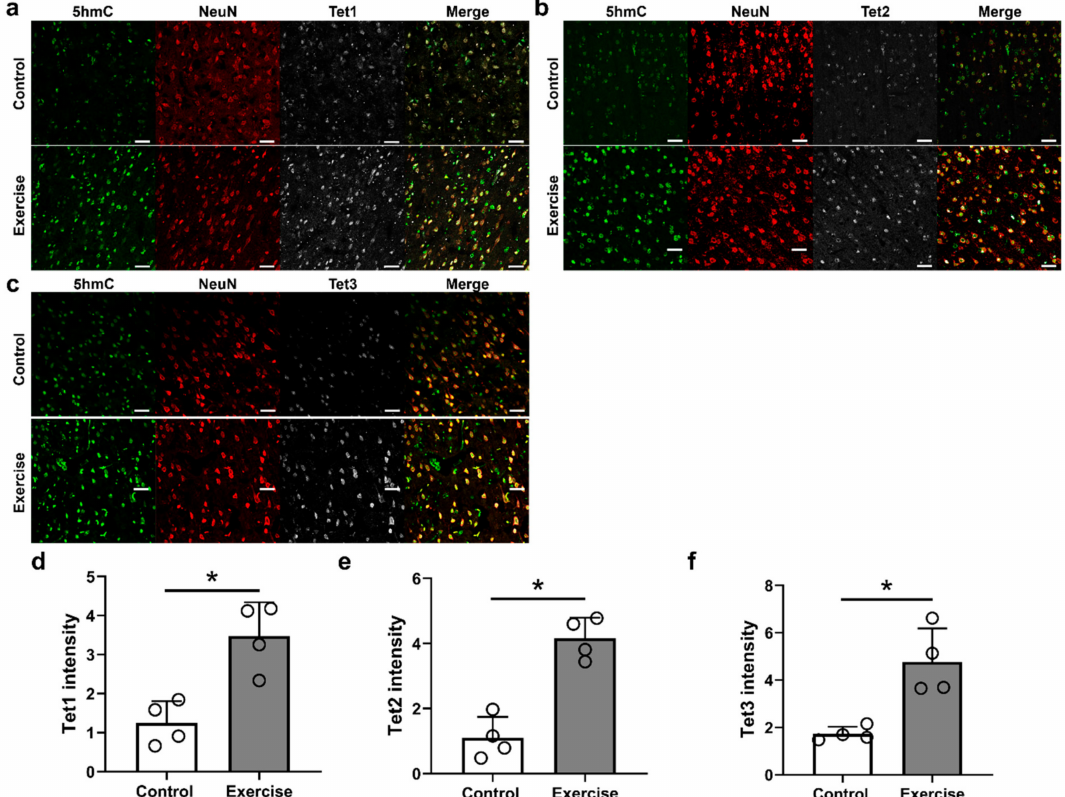
Figure 4. Representative immunofluorescent images showing triple staining of 5hmC (green), NeuN (red) and ( a ) Tet1 (gray), ( b ) Tet2 (gray), or ( c ) Tet3 (gray) in the primary motor cortex 12 weeks after injury in the control and exercise groups. ( d ) Tet1, ( e ) Tet2 and ( f ) Tet3 intensity of 5hmC-stained neurons in the primary motor cortexes of rats in the control and exercise groups ( n = 4 per group). * p < 0.05 between the control and exercise groups by Mann–Whitney U test. White scale bars = 50 µ